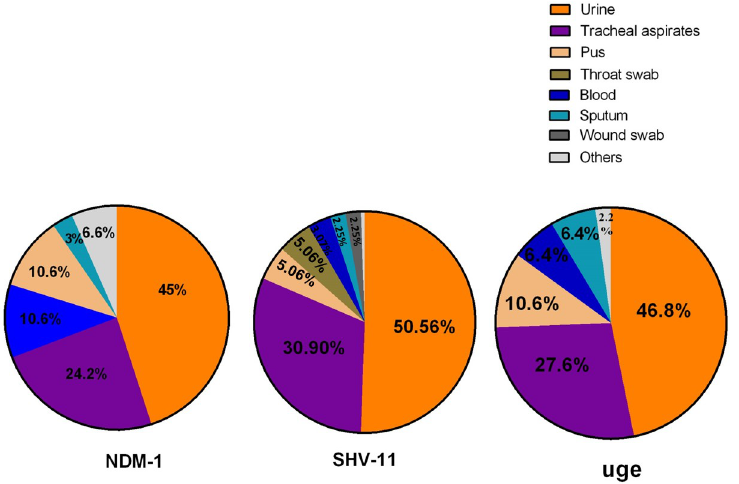
Fig 5. Frequency of NDM-1, SHV-11 and uge genes in different types samples of Klebsiella isolates.